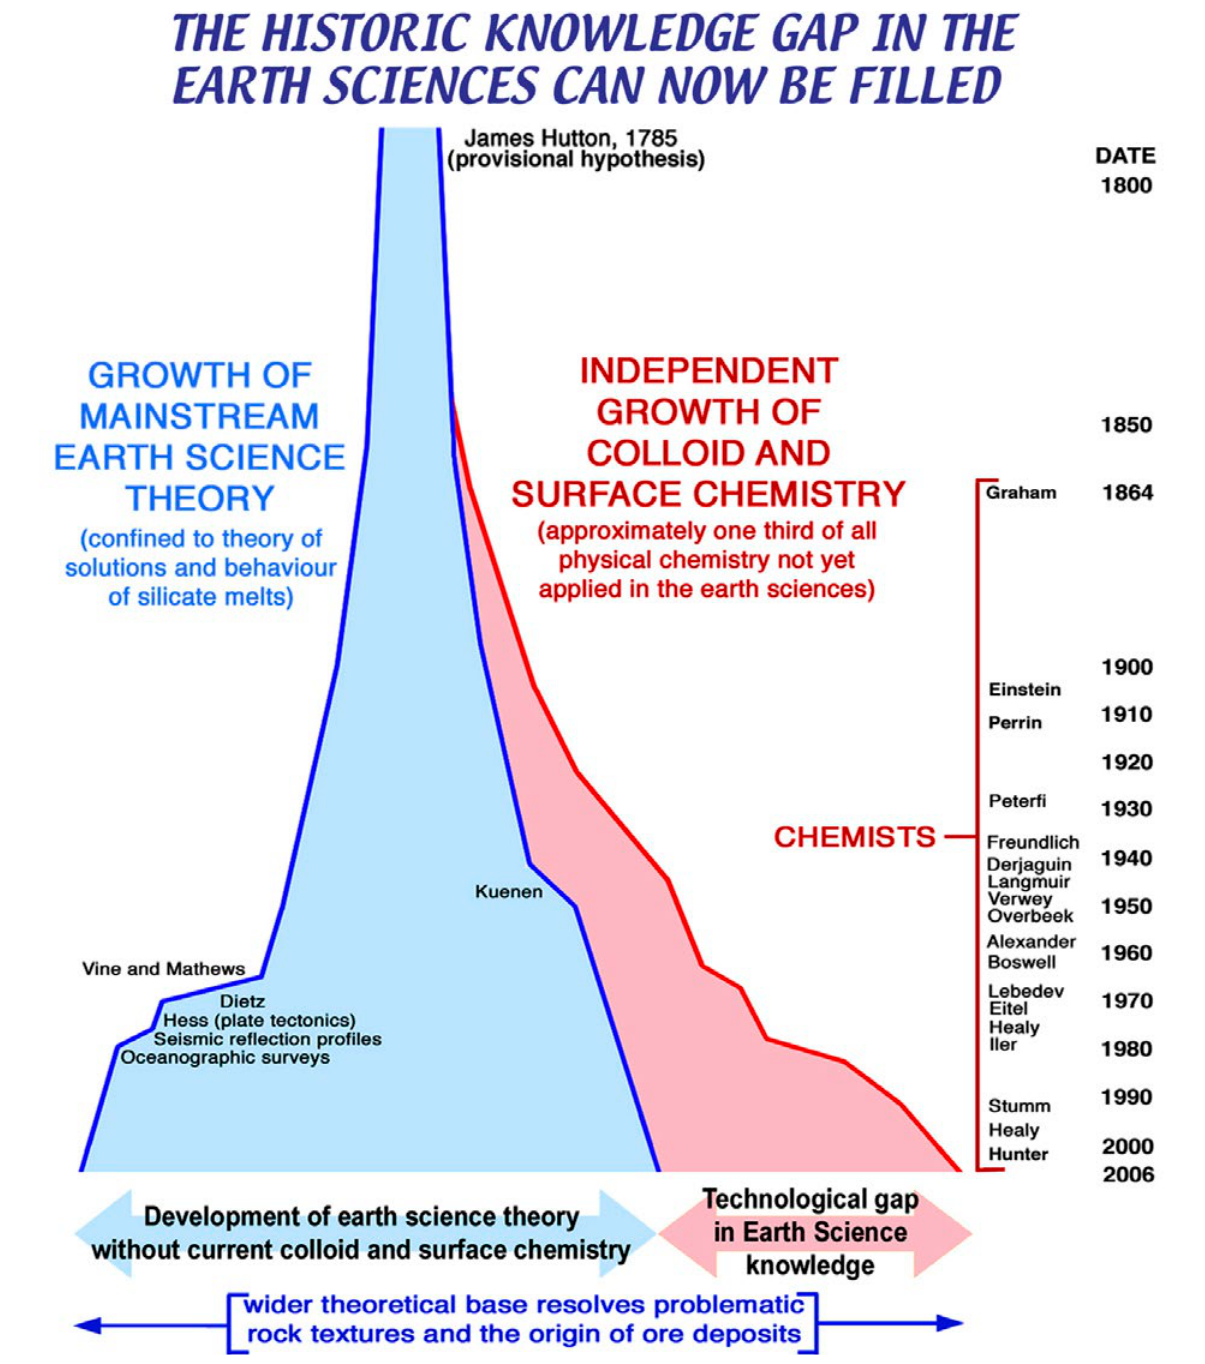
Figure 33. The independent growth of knowledge in the Earth sciences and in colloid science has left a widening gap in our understanding of how rocks and mineral deposits were formed. This can now be